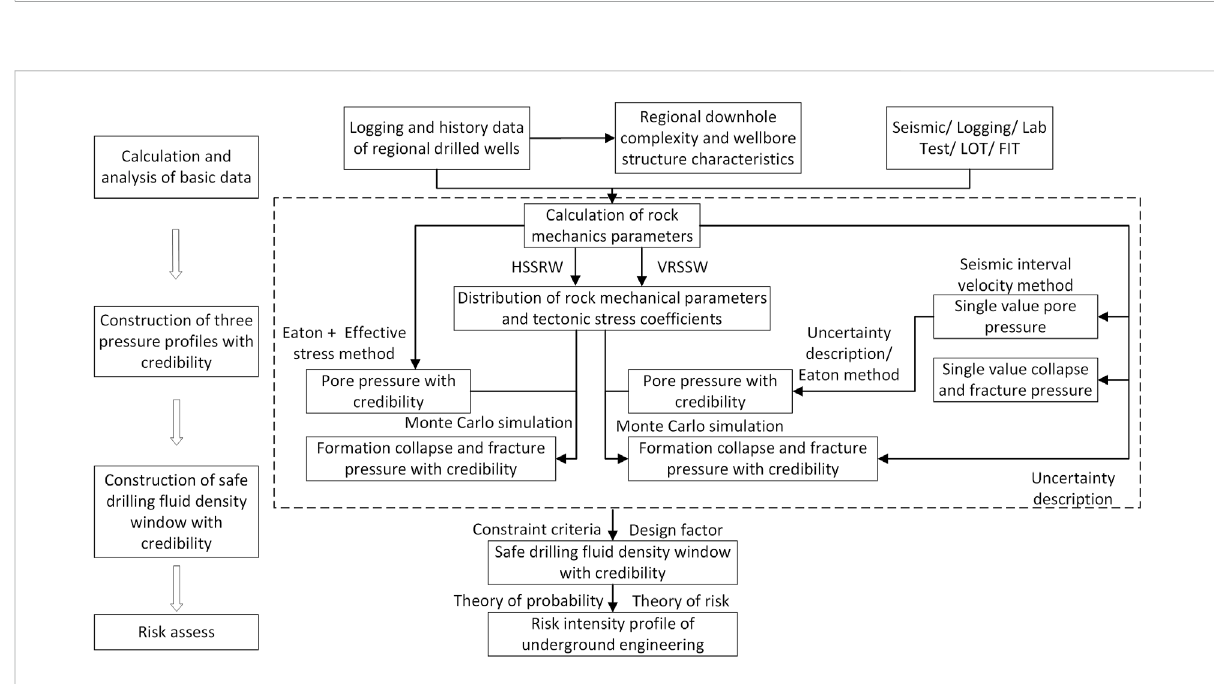
FIGURE 2 Schematic diagram of pre-drilling risk quantitative evaluation